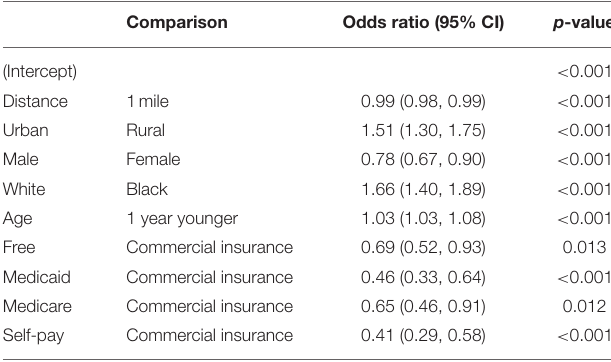
TABLE 2 | Logistic regression results on smoking cessation class attendance.